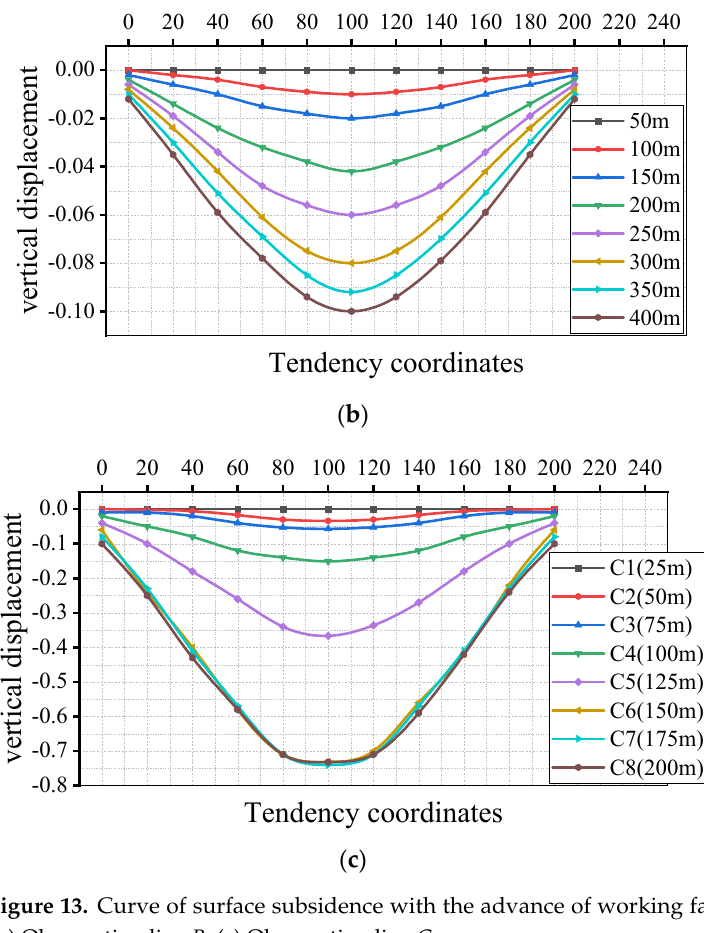
Figure 13. Curve of surface subsidence with the advance of working face. ( a ) Observation line A . ( b ) Observation line B . ( c ) Observation line C.